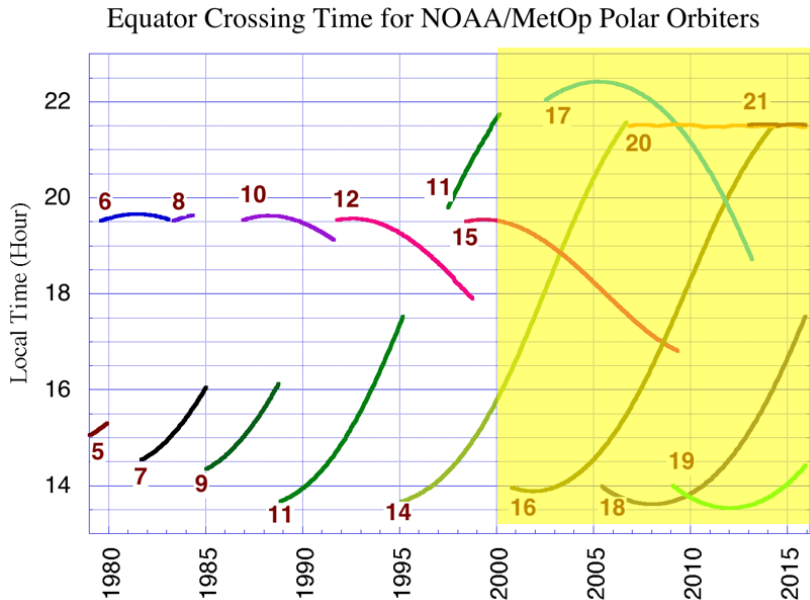
Figure 1. Local time of ascending node for NOAA and MetOp satellites from 1979 through 2016. The number represents the satellite name (e.g., 5 = NOAA-5; 19 = NOAA-19; 20 = MetOp-A; and 21 = MetOp-B). The period of the hydrological bundle CDR (HBC) is shaded in yellow.